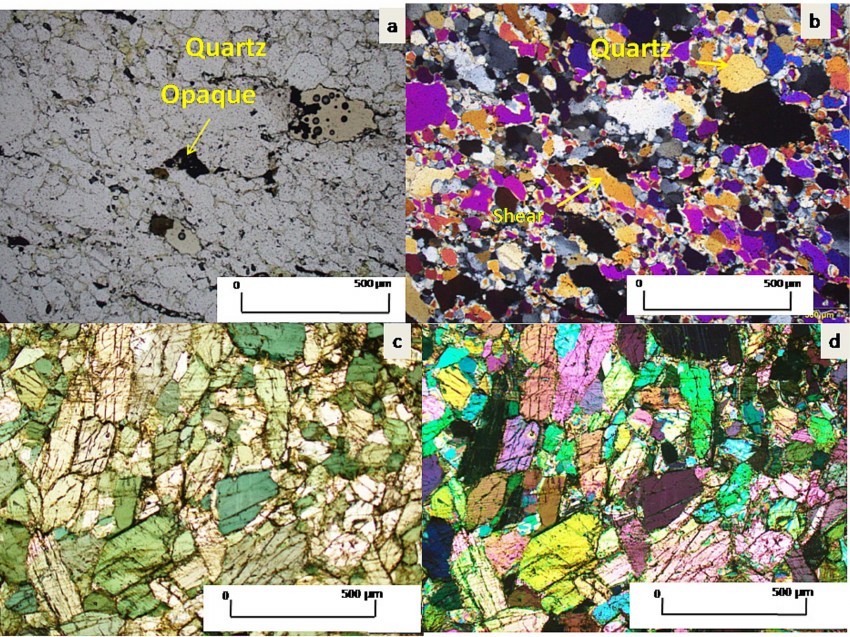
Figure 4. ( a ) Plain-polarized optical thin section of quartzite. ( b ) Cross-polarized optical thin section of quartzite in which evidence of shearing is prominent. ( c ) Plain-polarized optical thinsection of amphibolite. ( d ) Cross-polarized optical thin section of amphibolite.